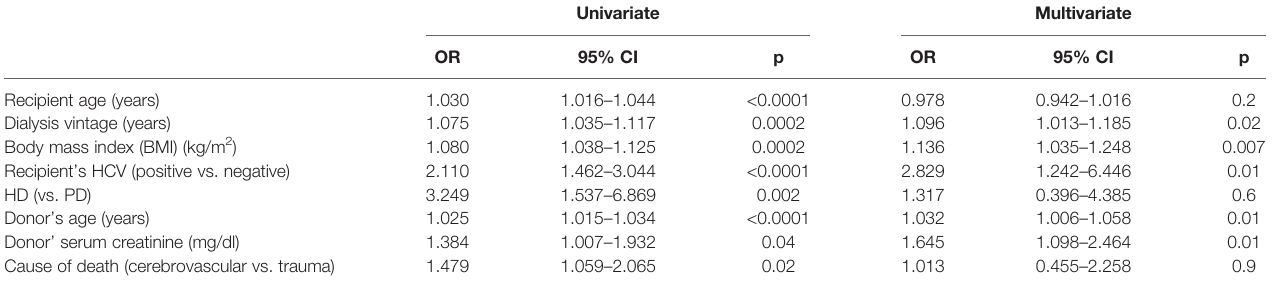
TABLE 3 | The univariate and multivariate analyses of donors ’ and recipients ’ features associated with